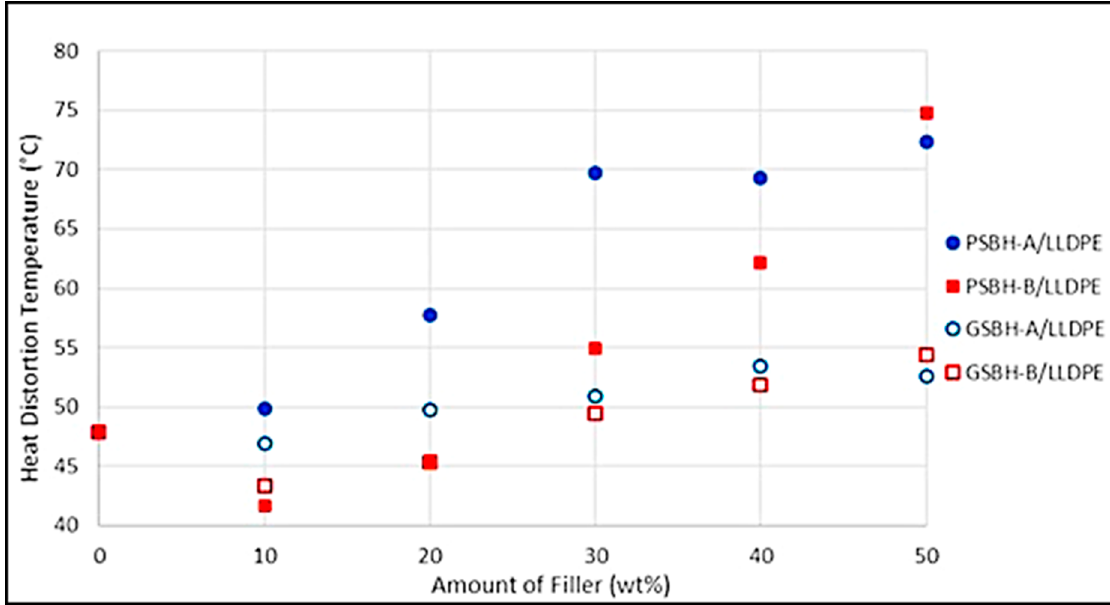
Figure 10. Heat distortion temperature of LLDPE/PSBH composites.